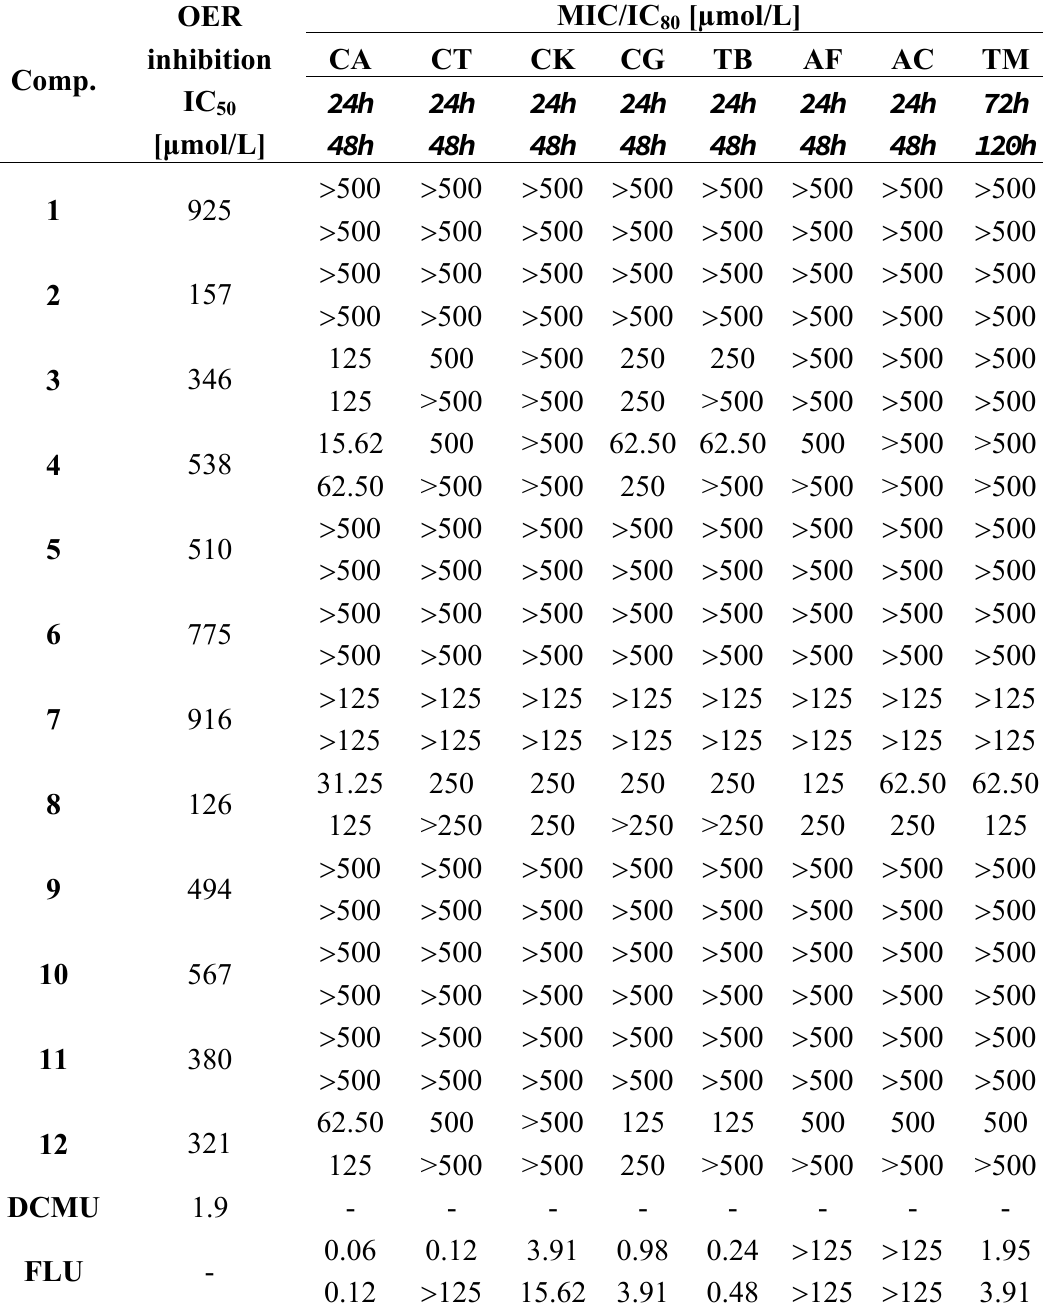
Table 2. IC values related to OER inhibition in spinach chloroplasts in comparison with 50 3-(3,4-dichlorophenyl)-1,1-dimethylurea (DCMU) standard and in vitro antifungal activity ) of compounds 1-12 compared with fluconazole (FLU) (IC 80